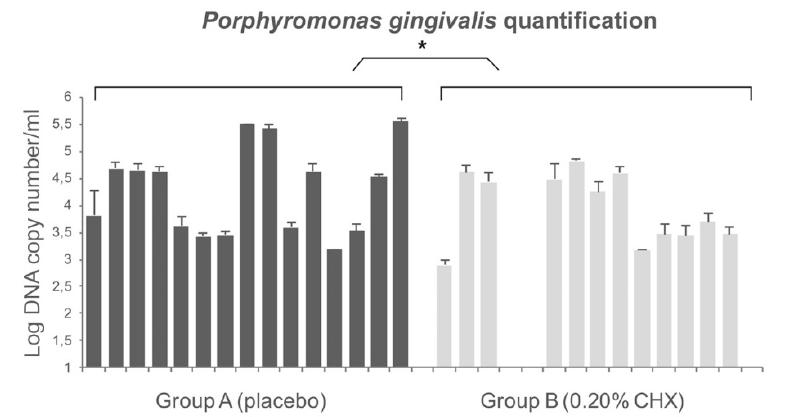
Figure 5. Quantification of P. gingivalis on healing abutment by TaqMan Polymerase Chain Reaction (PCR). The differences in terms of colony forming units (CFU) between two groups were statistically significant as reported by * in the picture.